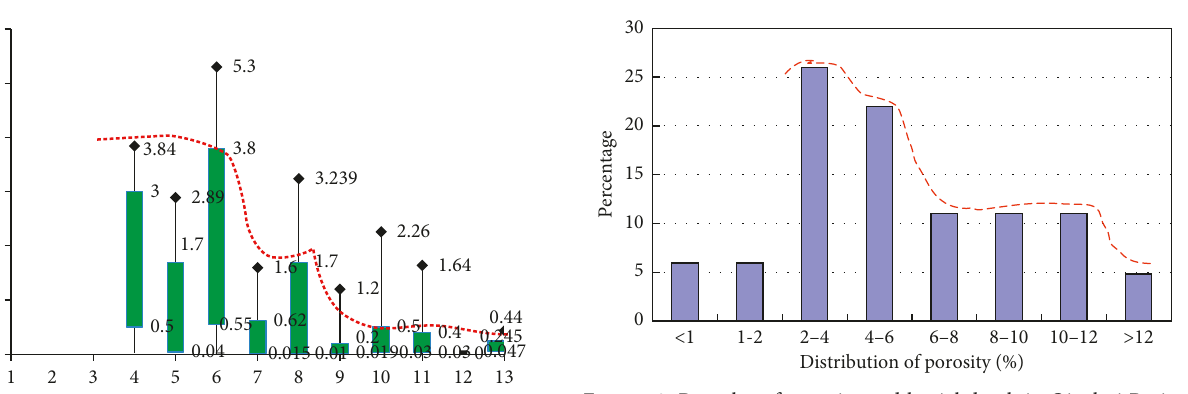
Figure 3: Box plot of porosity and burial depth in Qinshui Basin.